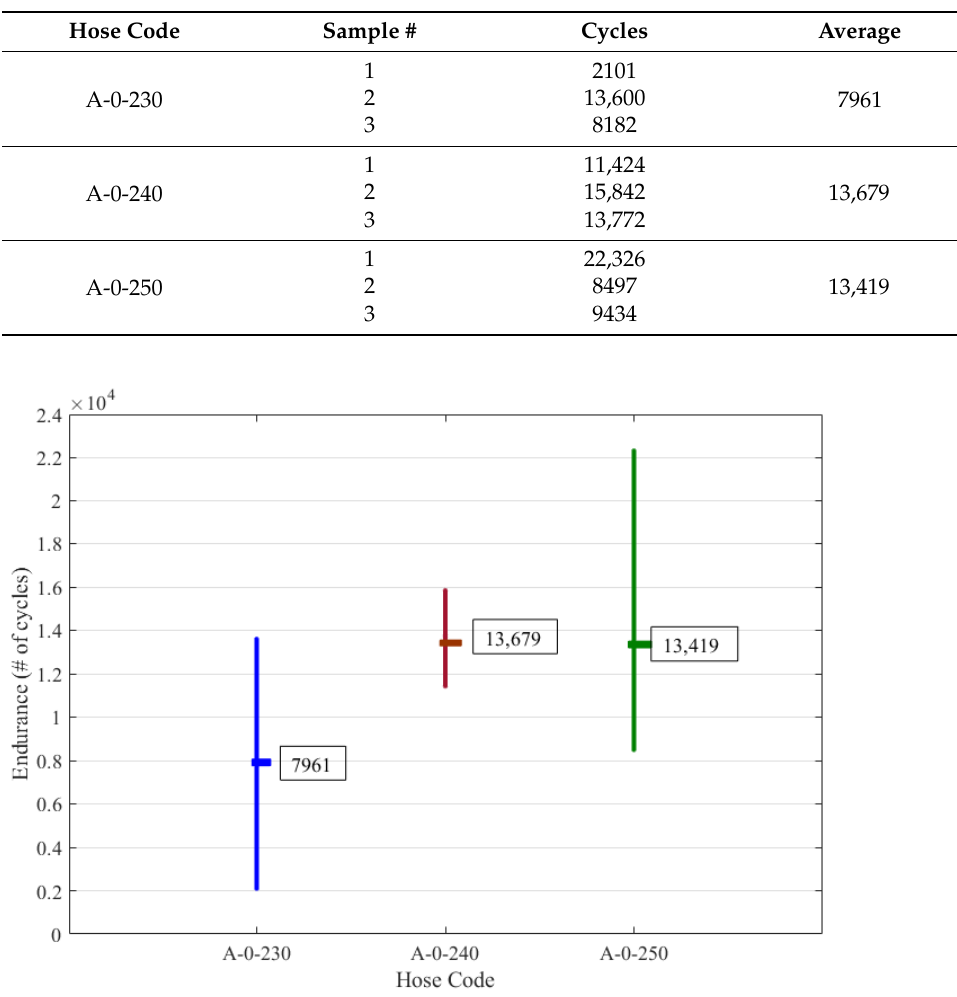
Figure 9. Influence of printing temperature: average, minimum, and maximum number of cycles. Based on the results previously obtained, a printing temperature of 240 °C was set as the one to use in the assessment of different designs and printing angles. This choice is justified by the fact that this printing temperature led to lower dispersion of the results when compared to 250 °C. Three samples of each hose configuration presented in Table 5 were tested for design and printing angle comparison (set 2). The results are presented in Table 6 and in Figure 10. Regarding the influence of the printing angle, a comparison between set 2 samples reveals that the 35° printing angle leads to a higher average endurance. This result should nevertheless be interpreted with caution as there is a big standard deviation of the B-35-240 results. Finally, the analysis of A-0-240 and B-0-240 results allows a direct comparison be- tween designs A and B, as shown in Figure 11. These results indicate that design B clearly leads to a longer endurance than design A, as the average endurance of design B is more than twice the one of design A. This is a very interesting result as it indicates that hose design shaping might play a crucial role in the endurance of the actuator. To further vali- date this conclusion, three extra samples for configurations A-0-240 and B-0-240 were tested. The average number of cycles for each 6 samples set was 14,244 and 34,197, respec- tively, thus confirming that design B is in fact promising when compared to design A. It should be highlighted that previous literature results [7] have already tried to prove if different hose designs lead to better endurance. However, in that study, the ma- terial used to build the prototypes led to very short life cycles, thus compromising any valid conclusions. Given the above discussion, the use of design B, printed at 240 °C and with a print angle of 35° leads to the best results obtained in this comparison. These results should nevertheless be considered as preliminary, since the big dispersion found in the longevity results prevents more robust conclusions. Table 5. Sample set 2: different hose configurations for printing angle and design assessment. Name